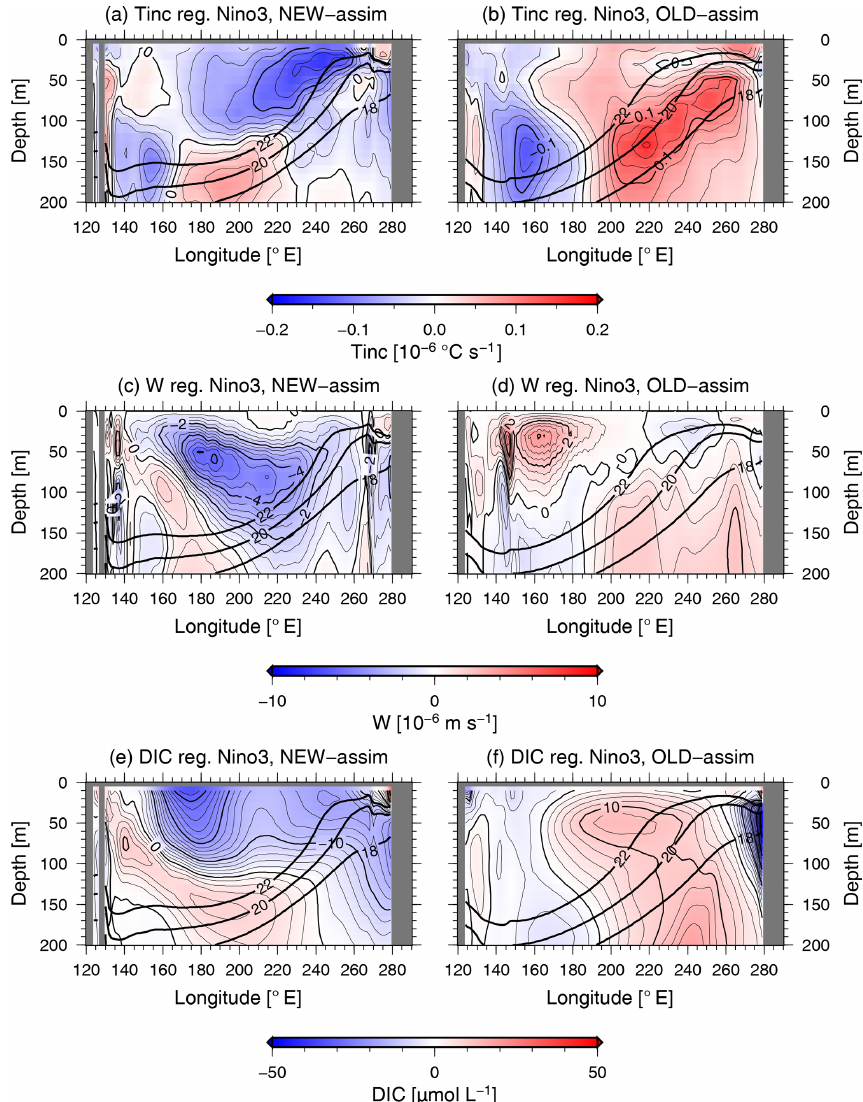
Figure 5. Equatorial temperature analysis increments (a, b) , vertical velocity anomalies (c, d) , and DIC anomalies (e, f) regressed onto the standardized NINO3-SST anomalies for NEW-assim (a, c, e) and OLD-assim (b, d, f) . The contour intervals are 0.02 × 10 − 6 ◦ Cs − 1 in panels (a) and (b) , 0.5 × 10 − 6 ms − 1 in panels (c) and (d) , and 2µmolL − 1 in panels (e) and (f) . The thick solid lines indicate the climatological mean of the 18, 20, and 22 ◦ C